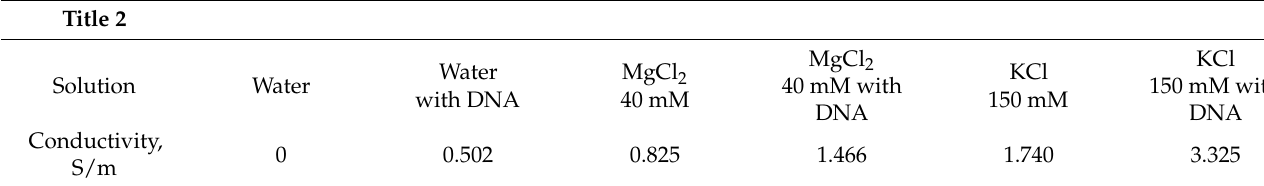
Table 2. dc-conductivity values of all the studied solutions at 25 ◦